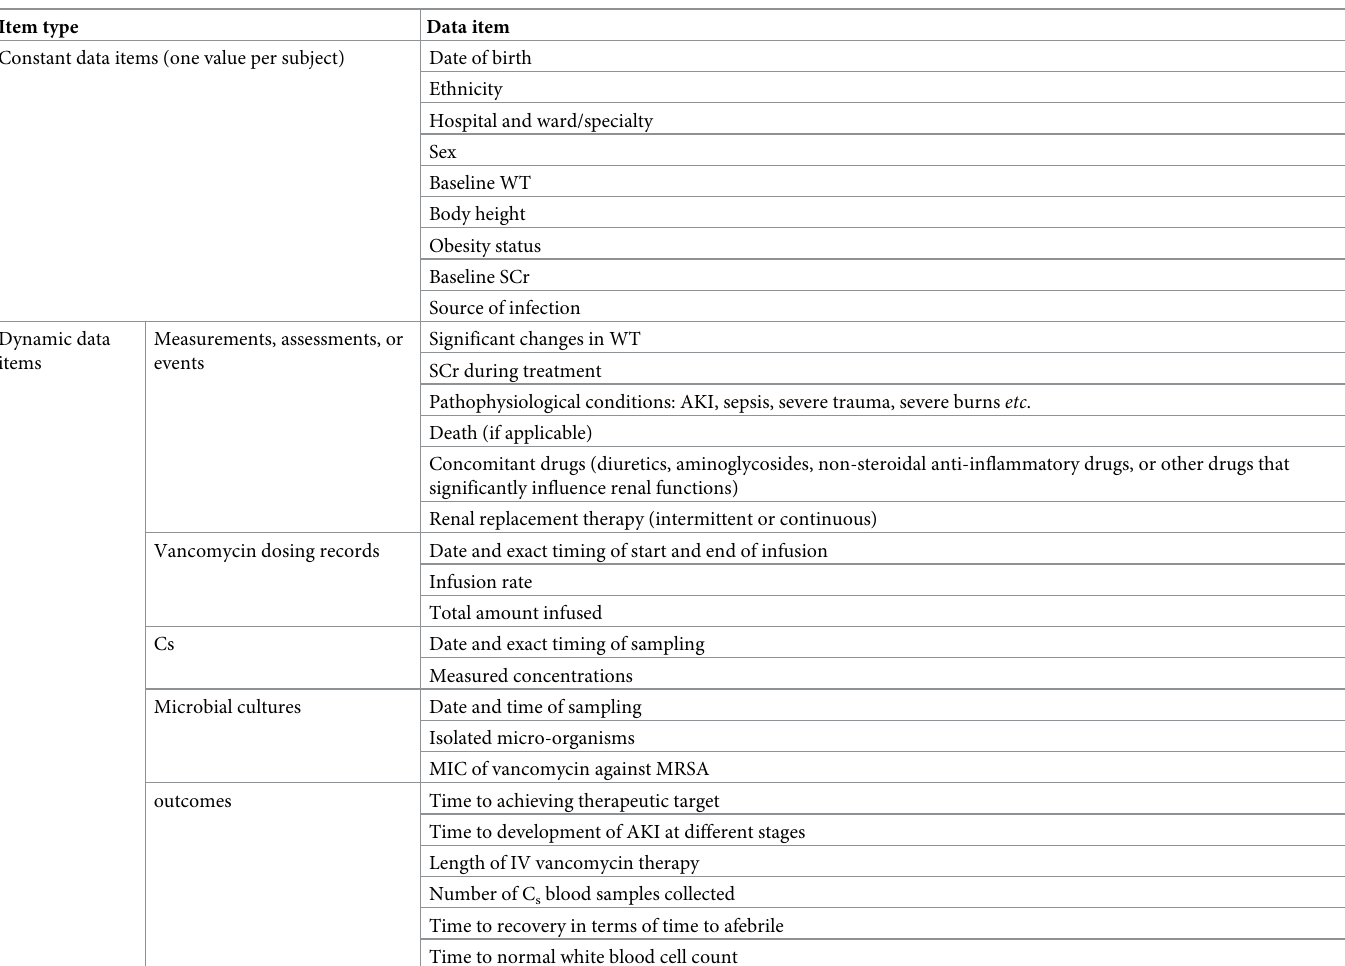
Table 1. Data items to be